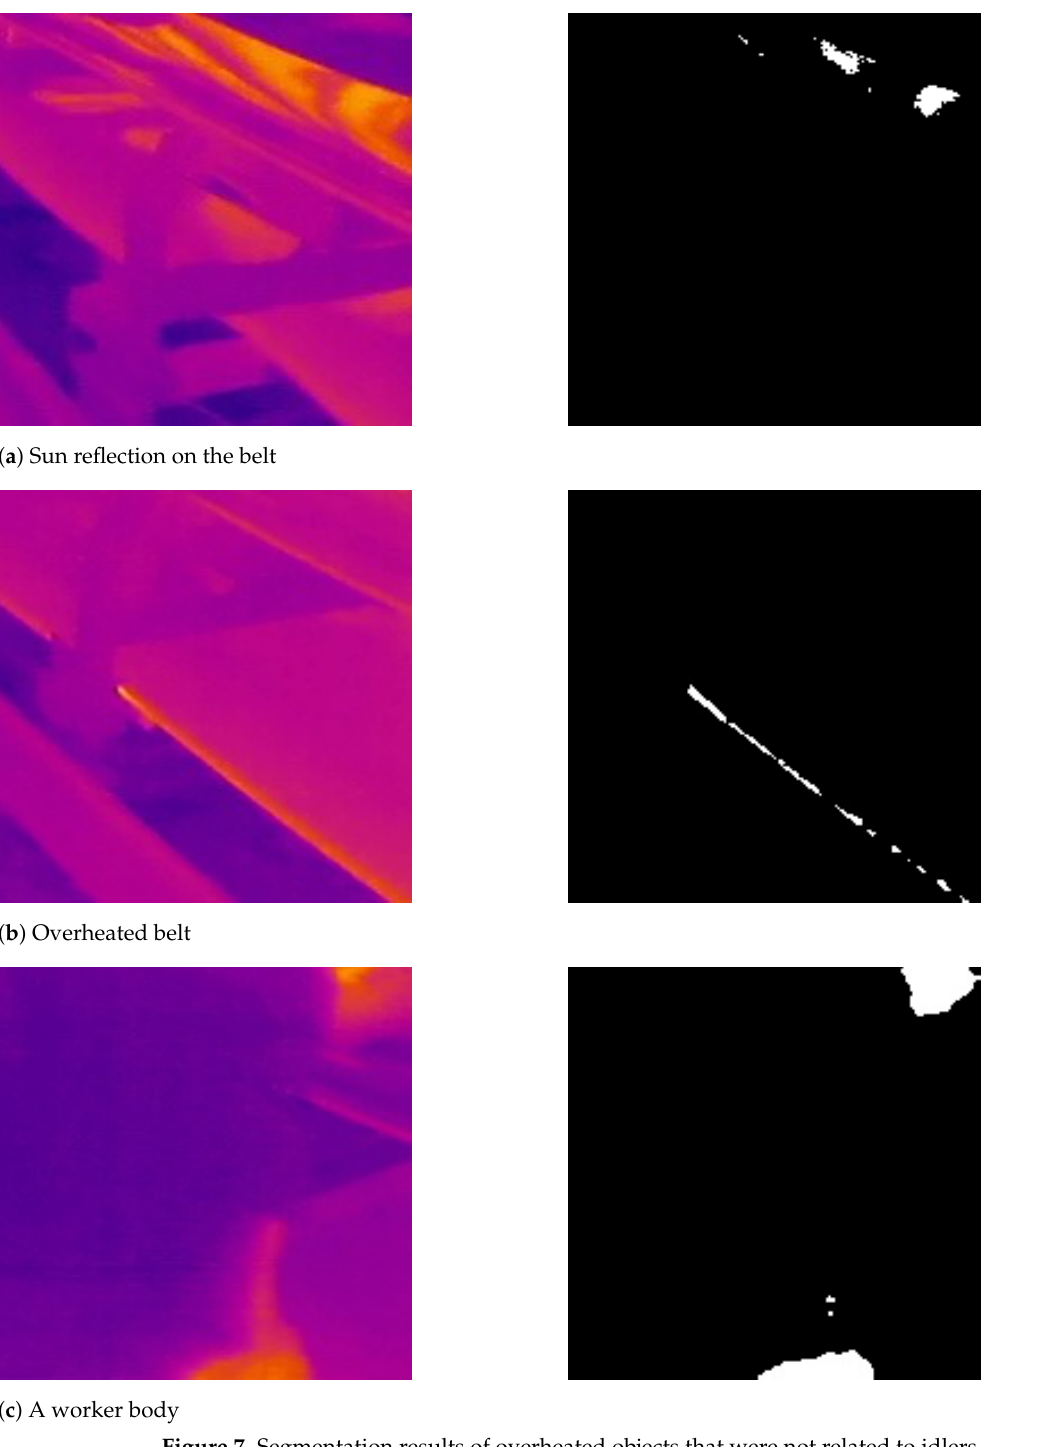
Figure 7. Segmentation results of overheated objects that were not related to